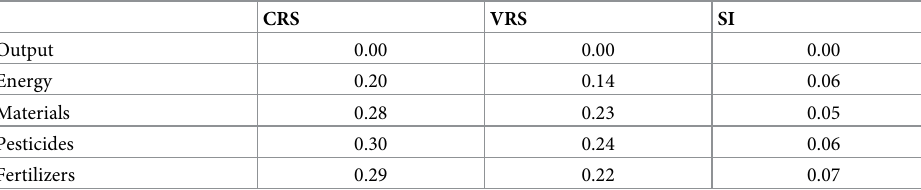
Table 2. Mean inefficiency scores for one output and four variable